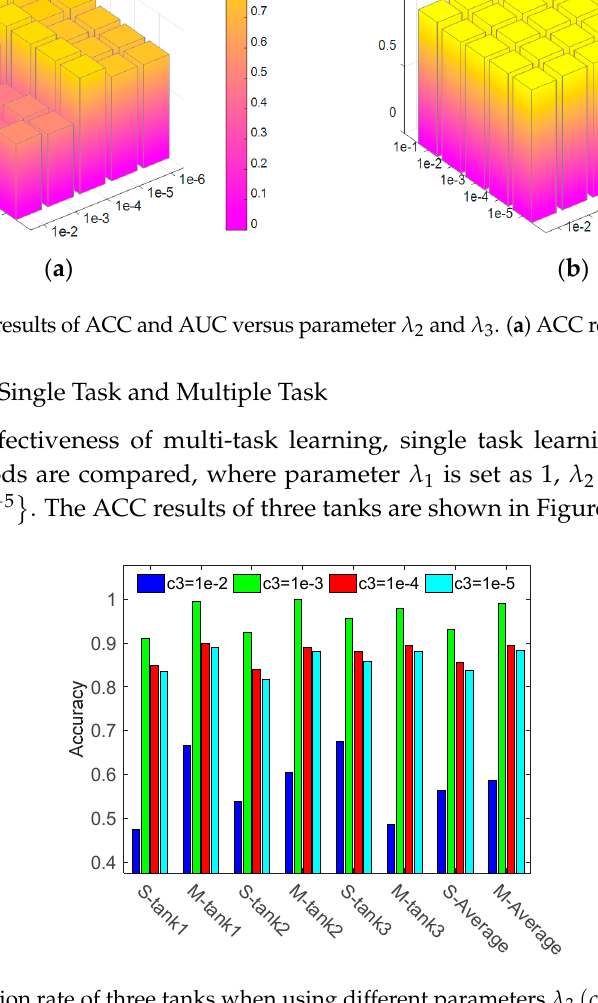
Figure 4. Recognition rate of three tanks when using different parameters λ 3 ( c 3 ) . The term ‘S-tank1’ (‘M-tank1’) denotes the recognition rate of tank1 in the framework of single (multiple) task learning, and ‘S-Average’ (‘M-Average’) means the average results of three tanks.